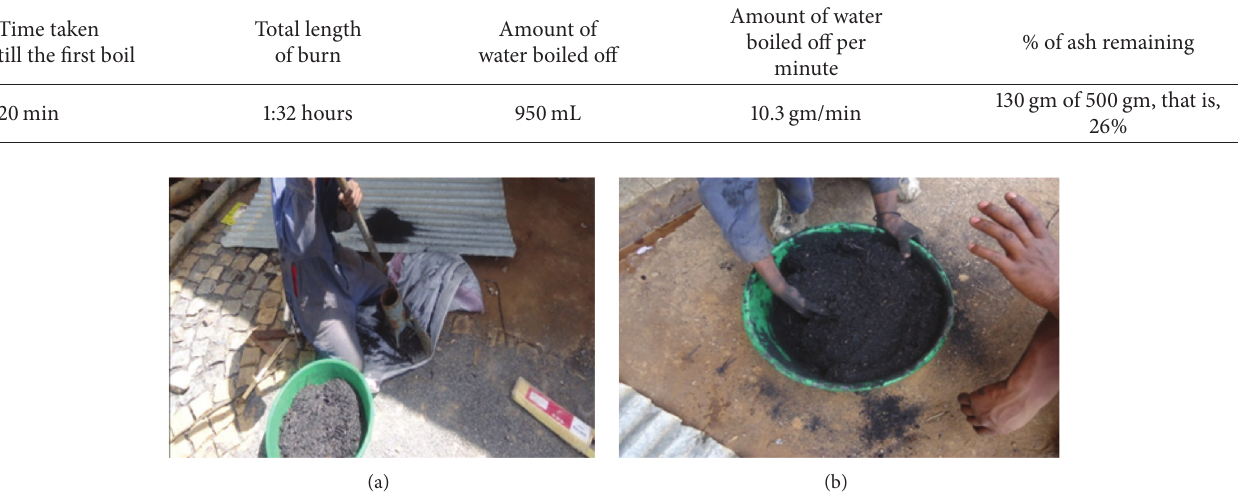
Table 3: Boiling test result.